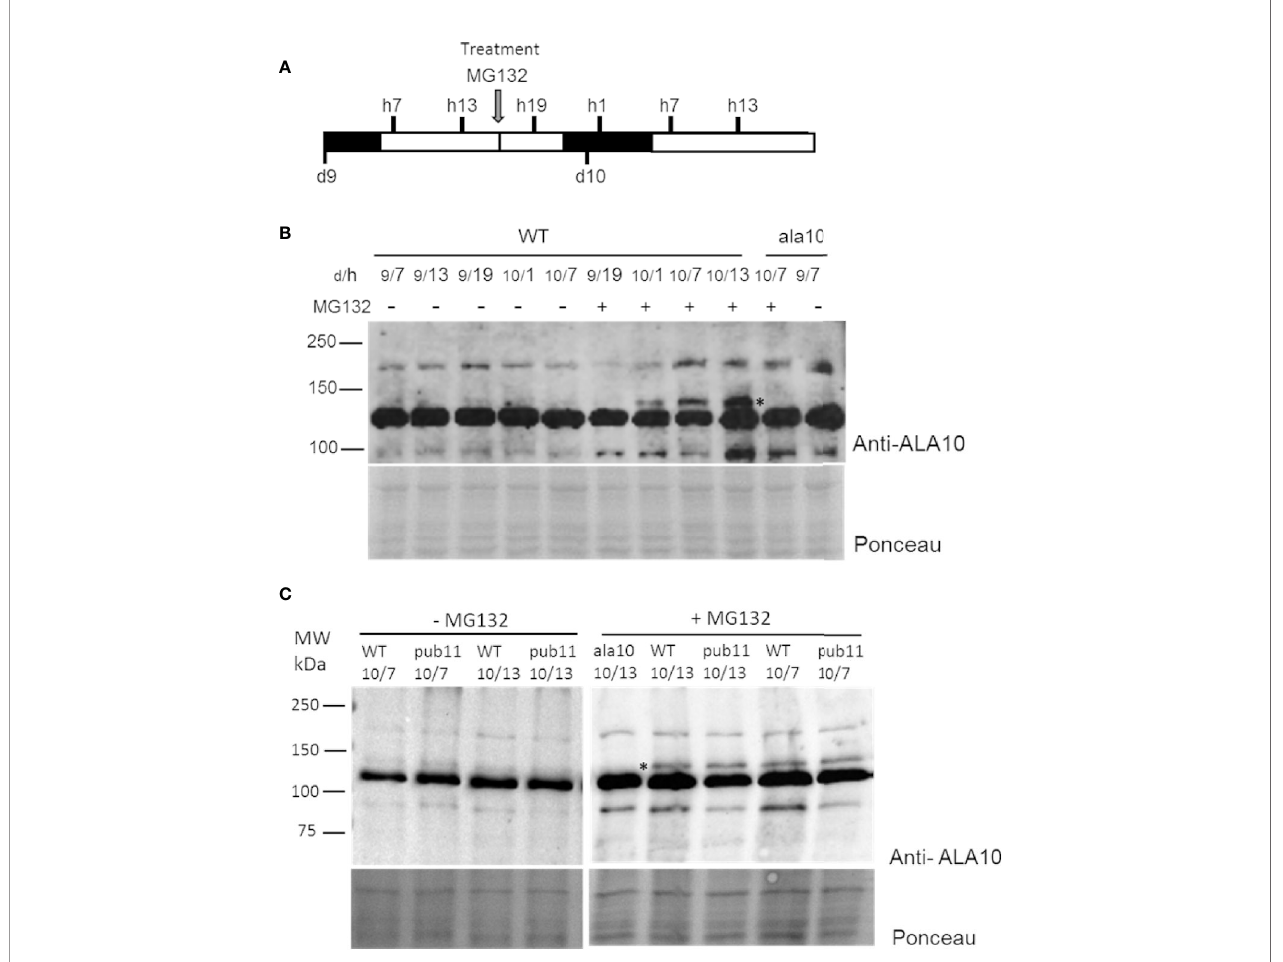
FIGURE 3 | Analysis of ALA10 protein level at different times along days 9 and 10 of culture treated with MG132. (A) Time schedule of plantlet collection. Plantlets were grown hydroponically with a 16 h light/8 h dark photoperiod. They were treated at day 9, hour 16 by transfer to a medium containing 50 µM MG132, 0.1% DMSO (+). As a control ( − ), plantlets were transferred into the same medium containing only 0.1% DMSO. Plantlets were collected at hour 7, 13 and 19 of day 9 (9/h) and at hour 1, 7 and 13 of day 10 (10/h) and immediately frozen in liquid nitrogen. (B) Western blot analysis with ALA10 antibodies of WT and ala10 membrane proteins of plantlets treated or not with MG132. (C) Western blot comparison of WT and pub11 with ALA10 antibodies. A star indicates ALA10 position identi fi ed by comparison of WT and ala10 . Ponceau staining is used for loading